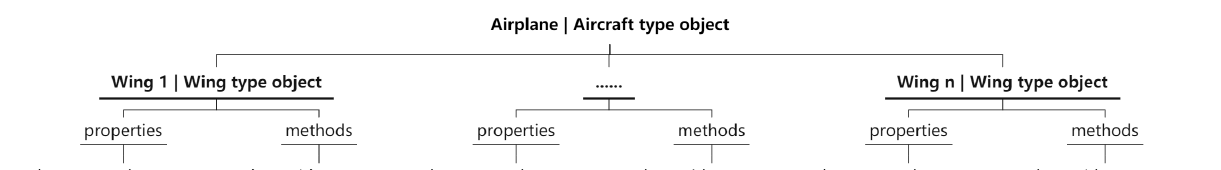
Figure 5. The data structure defined for modeling of multi-lifting surfaces.